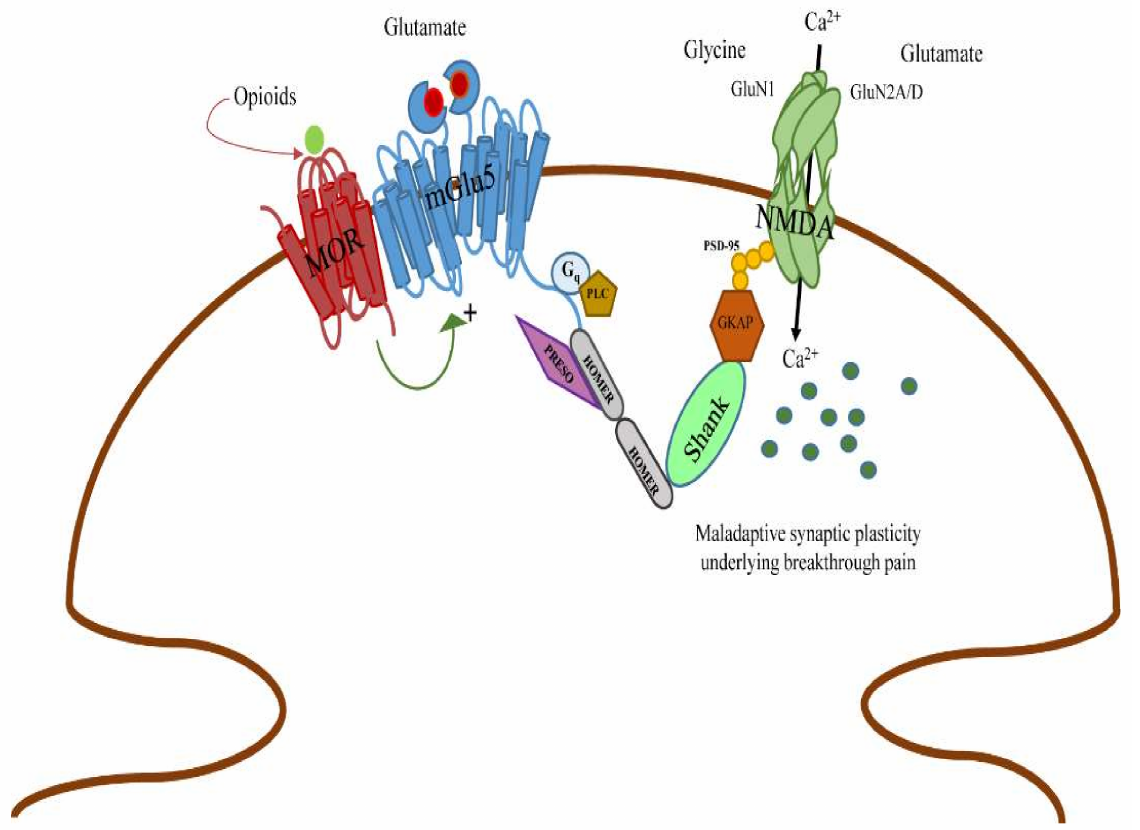
Figure 5. Hypothetical menage-a-trois among MOR, mGlu5 and NMDA receptors in the patho- physiology of breakthrough pain. MOR opioid receptors form functional heterodimers with mGlu5 receptors [21]. mGlu5 receptors, in turn, are physically linked to NMDA receptors via scaffolding proteins (long isoforms of Homer, Shank, GKAP, and PSD-95). Activation of mGlu5 receptors is known to facilitate NMDA receptor activation through protein kinase C and other mechanisms [23]. We hypothesize that opioid treatment supports the activity of NMDA receptors (via mGlu5 receptors), leading to enhanced calcium influx and activation of calcium-dependent enzymes (not shown). This may result in a maladaptive form of synaptic plasticity in nociceptive thalamic neurons underlying breakthrough